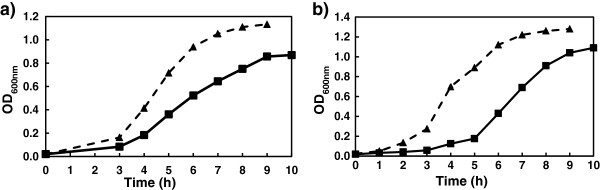
a) Effect of overexpression ofluxRon the growth rate ofV. scophthalmi.V. scophthalmiA089_23 (pMMB207)(black triangle)used as control strainvs V. scophthalmiA089_23 (pMMB207::luxR)(black square); b) Effect of expression of the lactonaseaiiAinV. scophthalmiA102. The growth rate was reduced in V. scophthalmi A089_23 overexpressing luxR (black square) compared to the control strain (black triangle) (Figure
1a), while strain A102_6.2 expressing the lactonase (black square) had a longer lag phase with respect to the control strain A102_pACYC (black triangle) (Figure
1b).